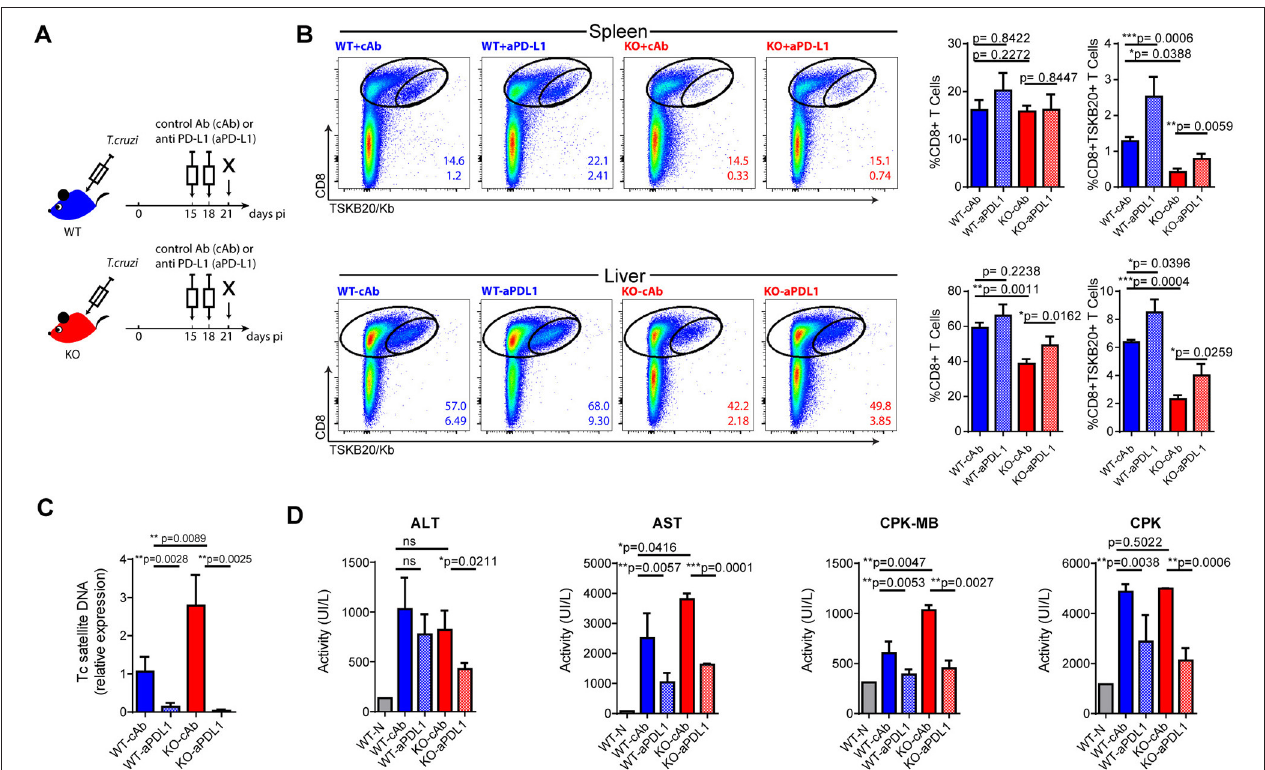
FIGURE 5 | Checkpoint blockade reinvigorates parasite-specific CD8 + T cell immunity and enhances parasite control in infected IL-17RA KO mice. (A) Layout of the checkpoint blockade experiment. (B) Representative plots and statistical analysis of CD8 and TSKB20/Kb staining in spleen and liver of the indicated experimental groups. Numbers within plots indicate the frequency of total CD8 + cells (up) and TSKB20-specific CD8 + T cells (down) at 21 dpi. Bar graphs represent data as mean ± SD , N = 7 mice. (C) Relative amount of T. cruzi satellite DNA in the spleens of the indicated experimental groups at 21 dpi. Murine GAPDH was used for normalization. Data are presented as mean ± SD relative to WT-cAb group, N = 7 mice. (D) Enzymatic activity (UI/L) of alanine transaminase (ALT), aspartate transaminase (AST), creatinine kinase-MB and creatinine phosphokinase (CPK) on plasma of the indicated experimental groups at 21 dpi. N = 7 mice. All P values were calculated with two-tailed T test. Data are representative of two independent